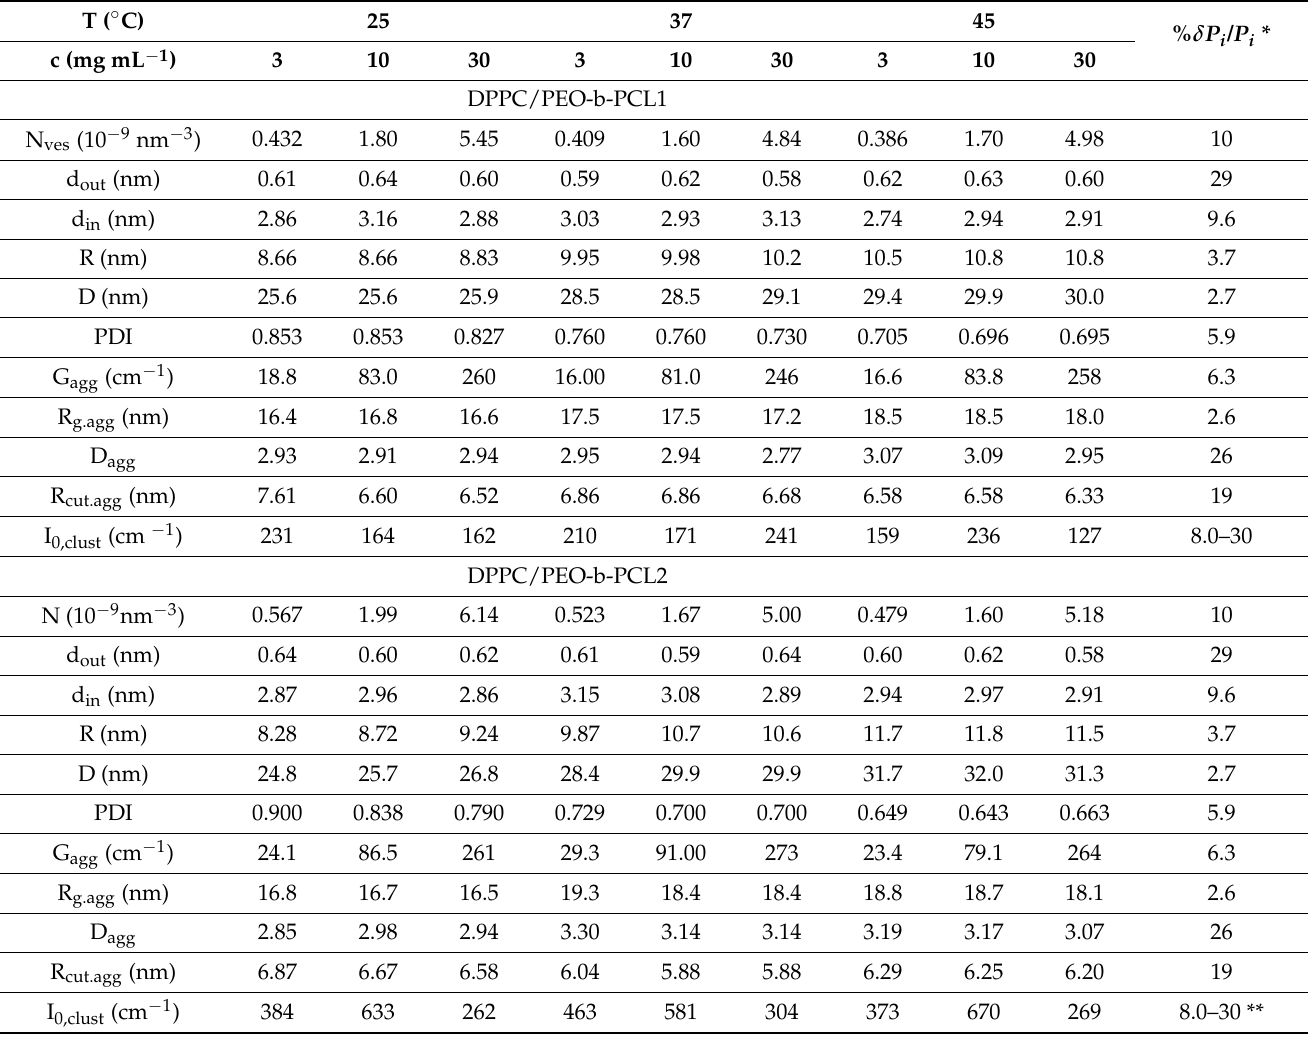
Table 1. SANS parameters extracted for DPPC/PEO-b-PCL1 solutions. Including number of vesicles per unit volume (N ves ), vesicles’ diameter (D), vesicles’ polydispersity (PDI), forward scattering from aggregates (G agg ), aggregates’ radius of gyration (R g,agg ), aggregates’ fractal dimension (D agg ), aggregates’ cut-off length (R cut,agg ) and clusters’ scattering at the lowest q (I 0,clust